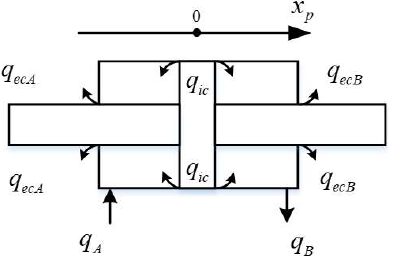
Figure 3. Hydraulic cylinder flow distribution.